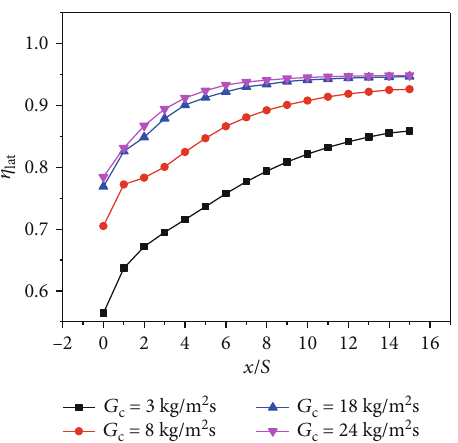
Figure 11: In fl uence of coolant fl ow rate on cooling e ffi ciency